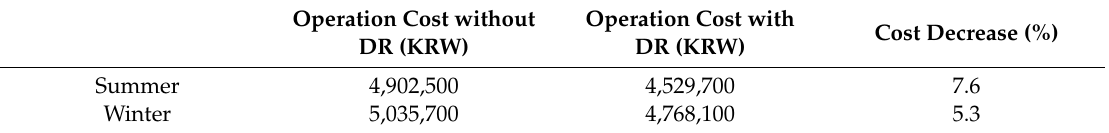
Table 2. Optimal operation cost comparison.